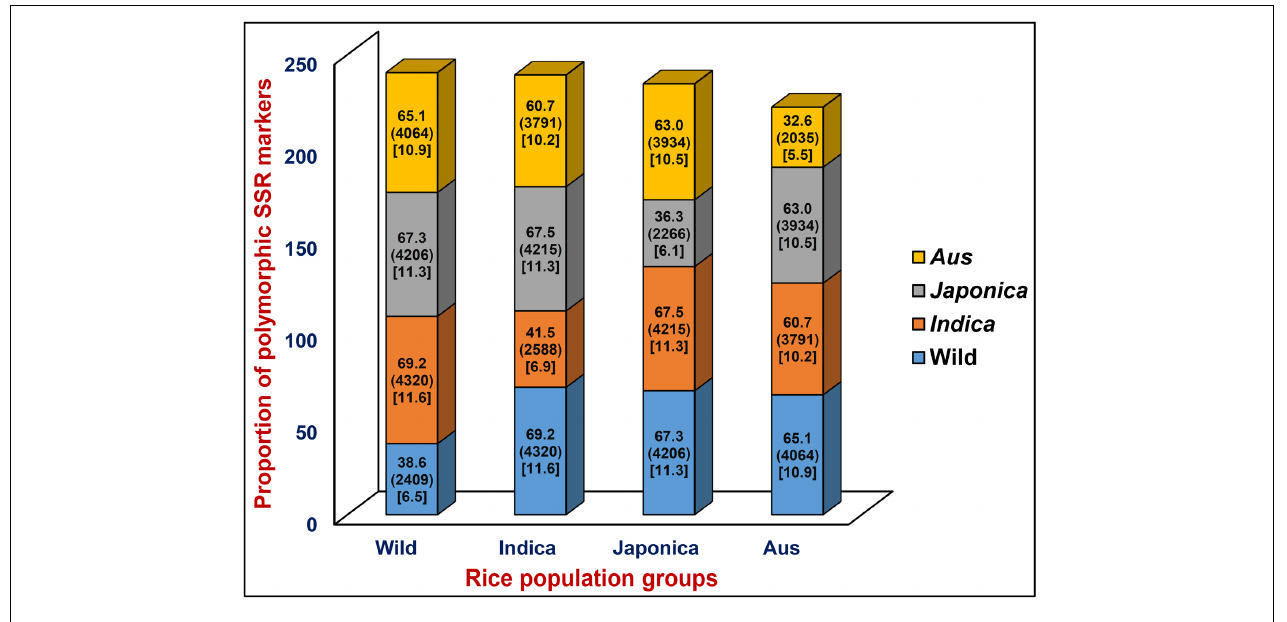
FIGURE 1 | In silico potential of polymorphism (denoted by %) detected by genome/gene-derived simple sequence repeat (SSR) markers within and between four different cultivated and wild rice population groups ( indica , aus , japonica, and wild). Digits mentioned within the parentheses indicate the polymorphic SSR markers represented by (number) and density [number of markers/Mb]. The markers polymorphic within and between four rice population groups are highlighted with diverse